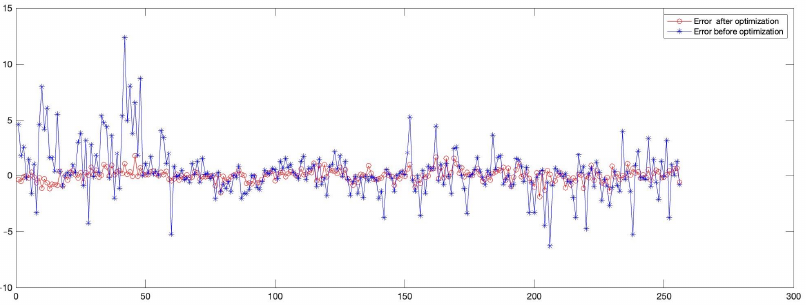
Figure 11. It is a comparison diagram of the prediction error of the BP neural network model and the CPA-BP model for the bonding strength of the plywood. Figures 12 and 13 clearly show that the prediction accuracy of CPA-BP is significantly better than BP, and the prediction results of BP neural network in both sets of data have a large error.